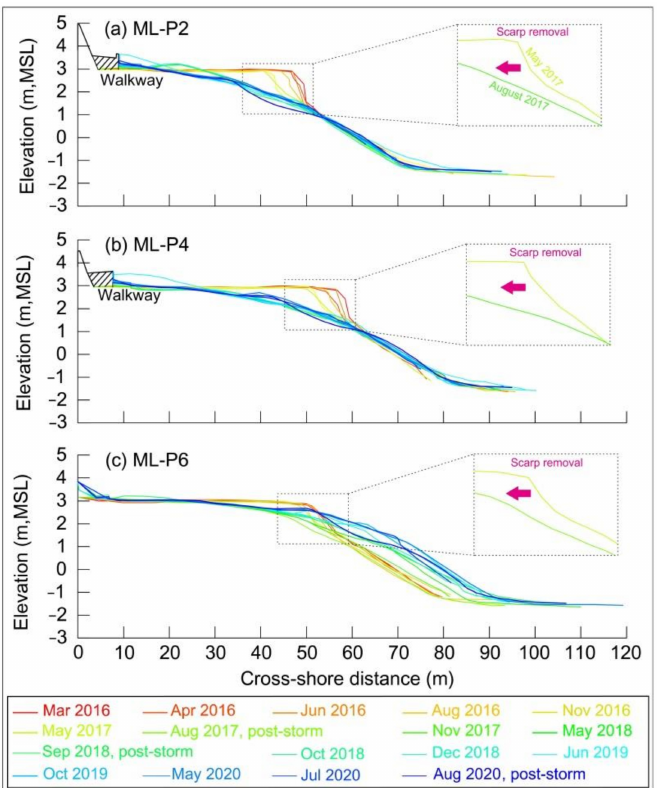
Figure 6. Examples of time-series beach profile morphology changes from March 2016 to August 2020, showing the evolution of scarps. The enlarged inserts highlighted the scarp removal after the first post-nourishment energetic storm (Typhoon Hato) in August